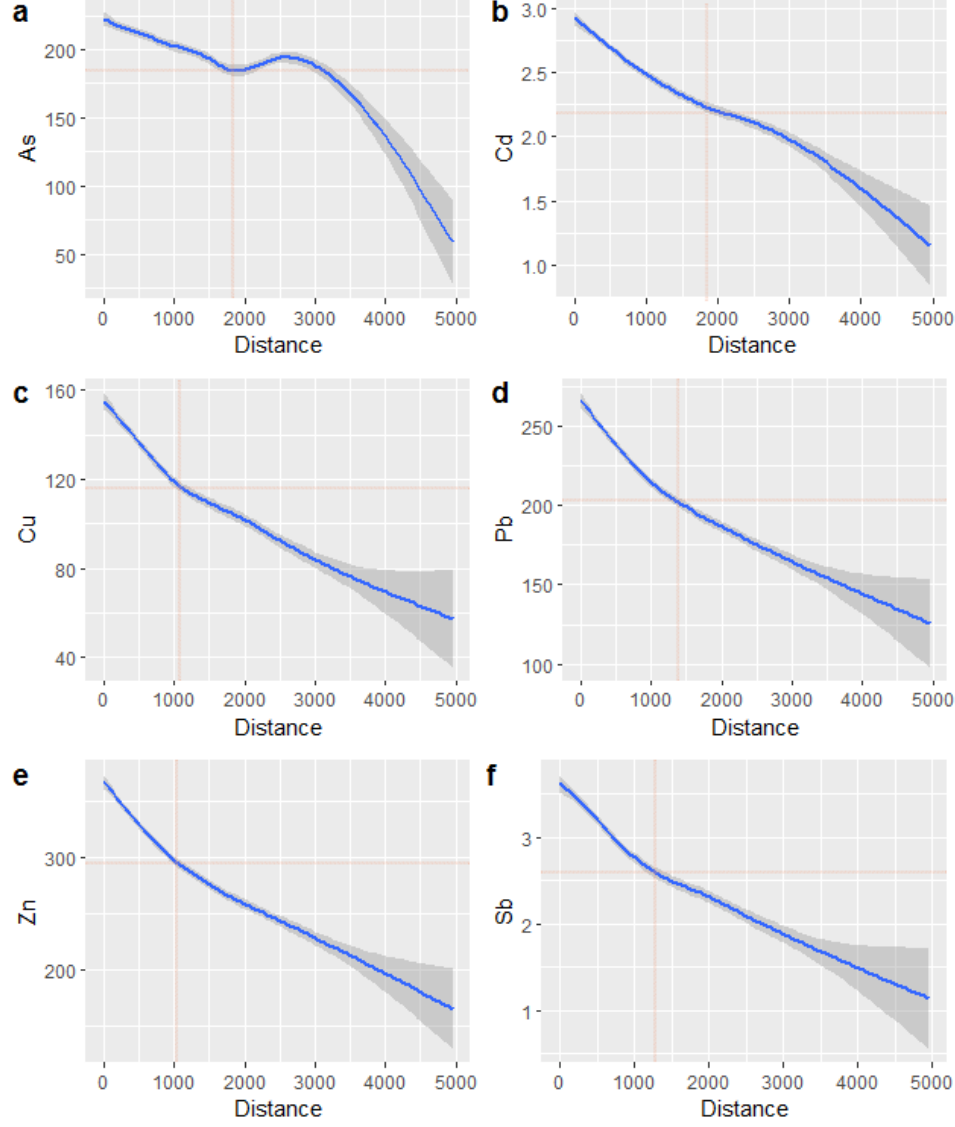
Figure 4. Variations in the contents of the heavy metals related to the industries of concern with distance from the nearest source. The red crosses denote the changing nodes of the variation trends. tance from the nearest source. ( a – f ) The red crosses denote the changing nodes of the variation